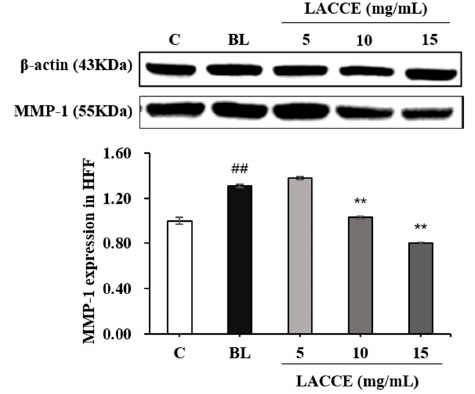
Figure 7. Effects of different concentrations of the LACCE on MMP-1. The data are expressed as mean ± standard deviation (SD) of three independent experiments ( n = 3). The data were analyzed using one-way analysis of variance (ANOVA) followed by Tukey’s test. ## p < 0.01 vs. control group (C). ** p < 0.01 vs. blue light model group (BL).